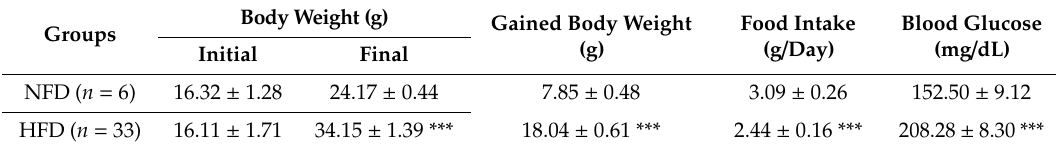
Table 2. Changes in body weight gain, food intake and blood glucose in C57BL / 6J mice for 6 weeks of on Type 2 diabetes induction.